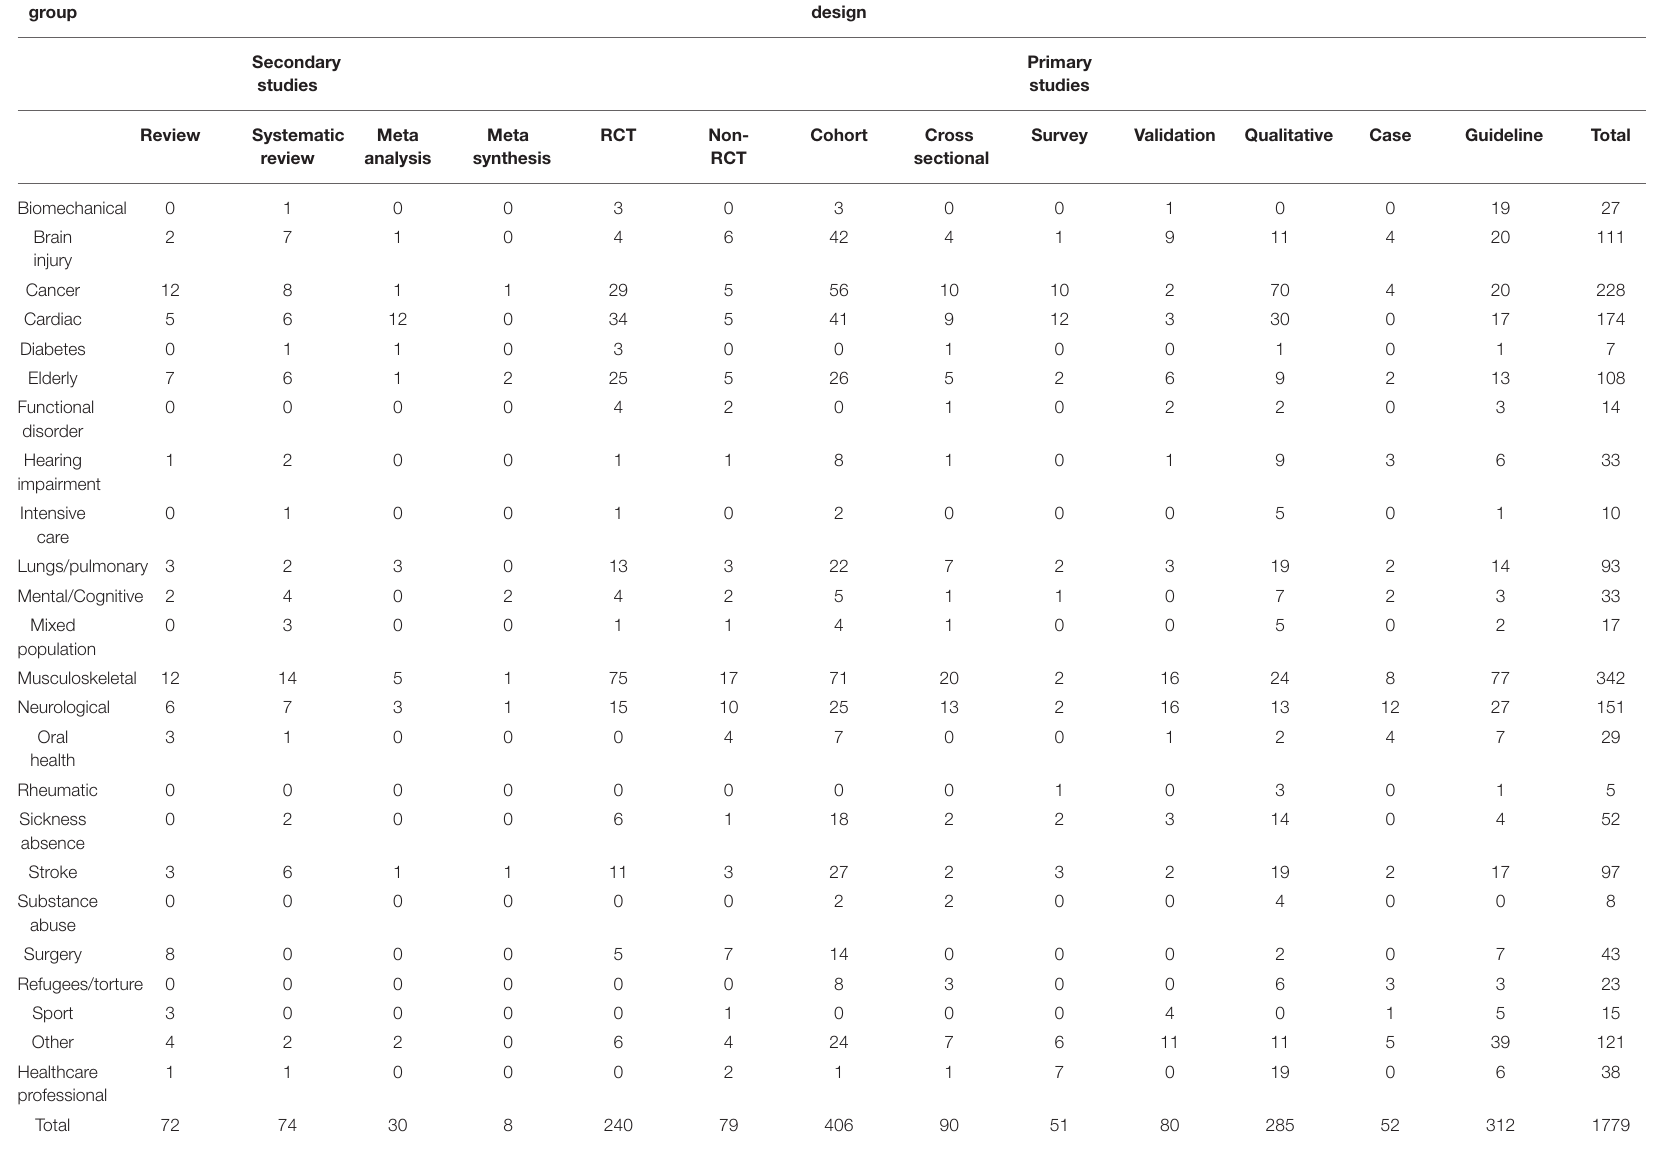
TABLE 1 | Study groups and